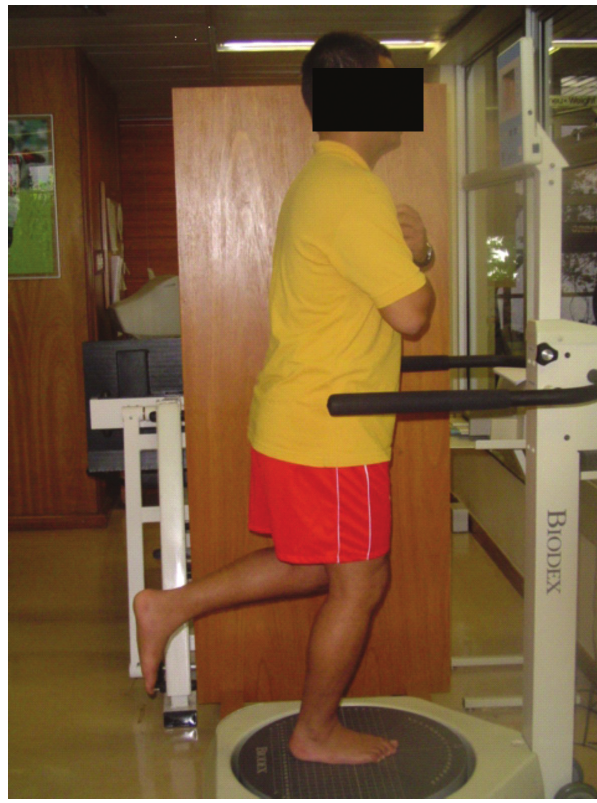
Figure 1 - The Biodex Balance